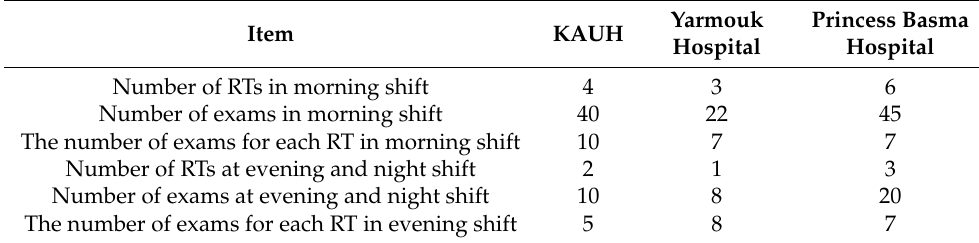
Table 3. Number of daily examinations to the number of RTs in CT.